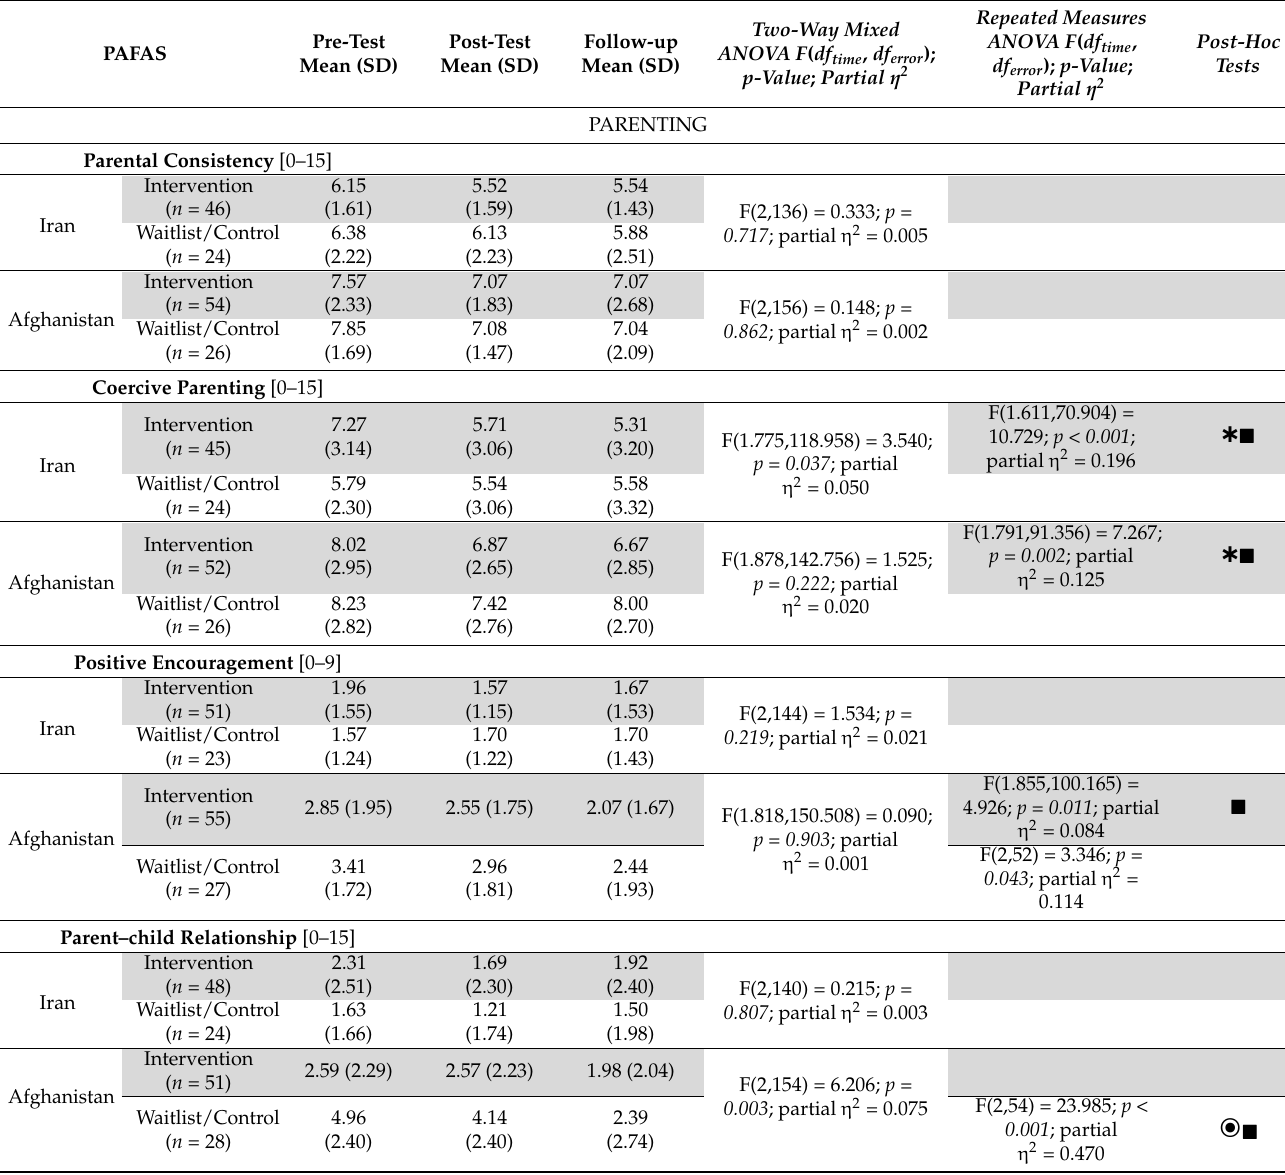
Table A3. Mean PAFAS scores over time for families originating from Iran or Afghanistan by intervention or waitlist/control group. ( Higher scores indicating lower levels of Parenting and Family Adjustment skills ).